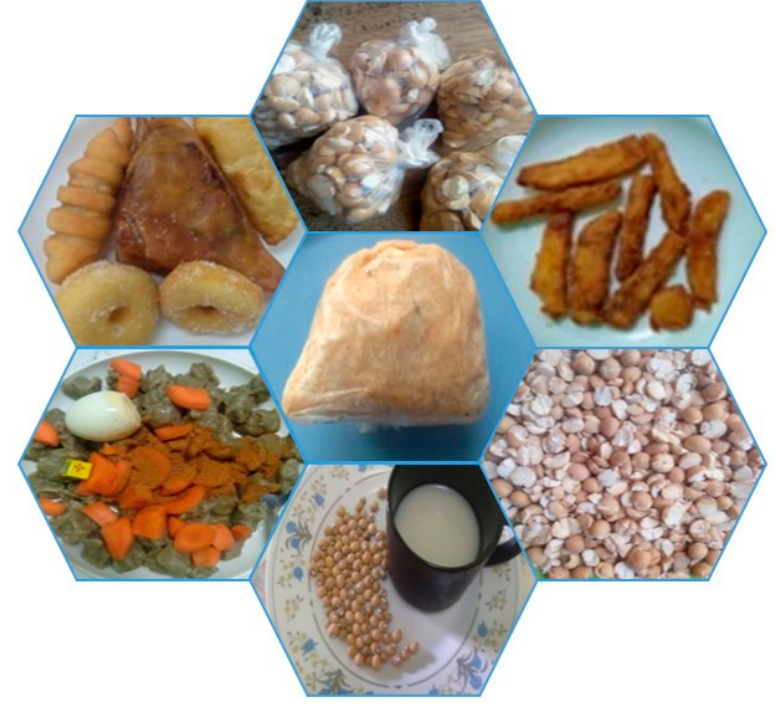
Figure 1. Some examples of processed food products made from Bambara groundnut.